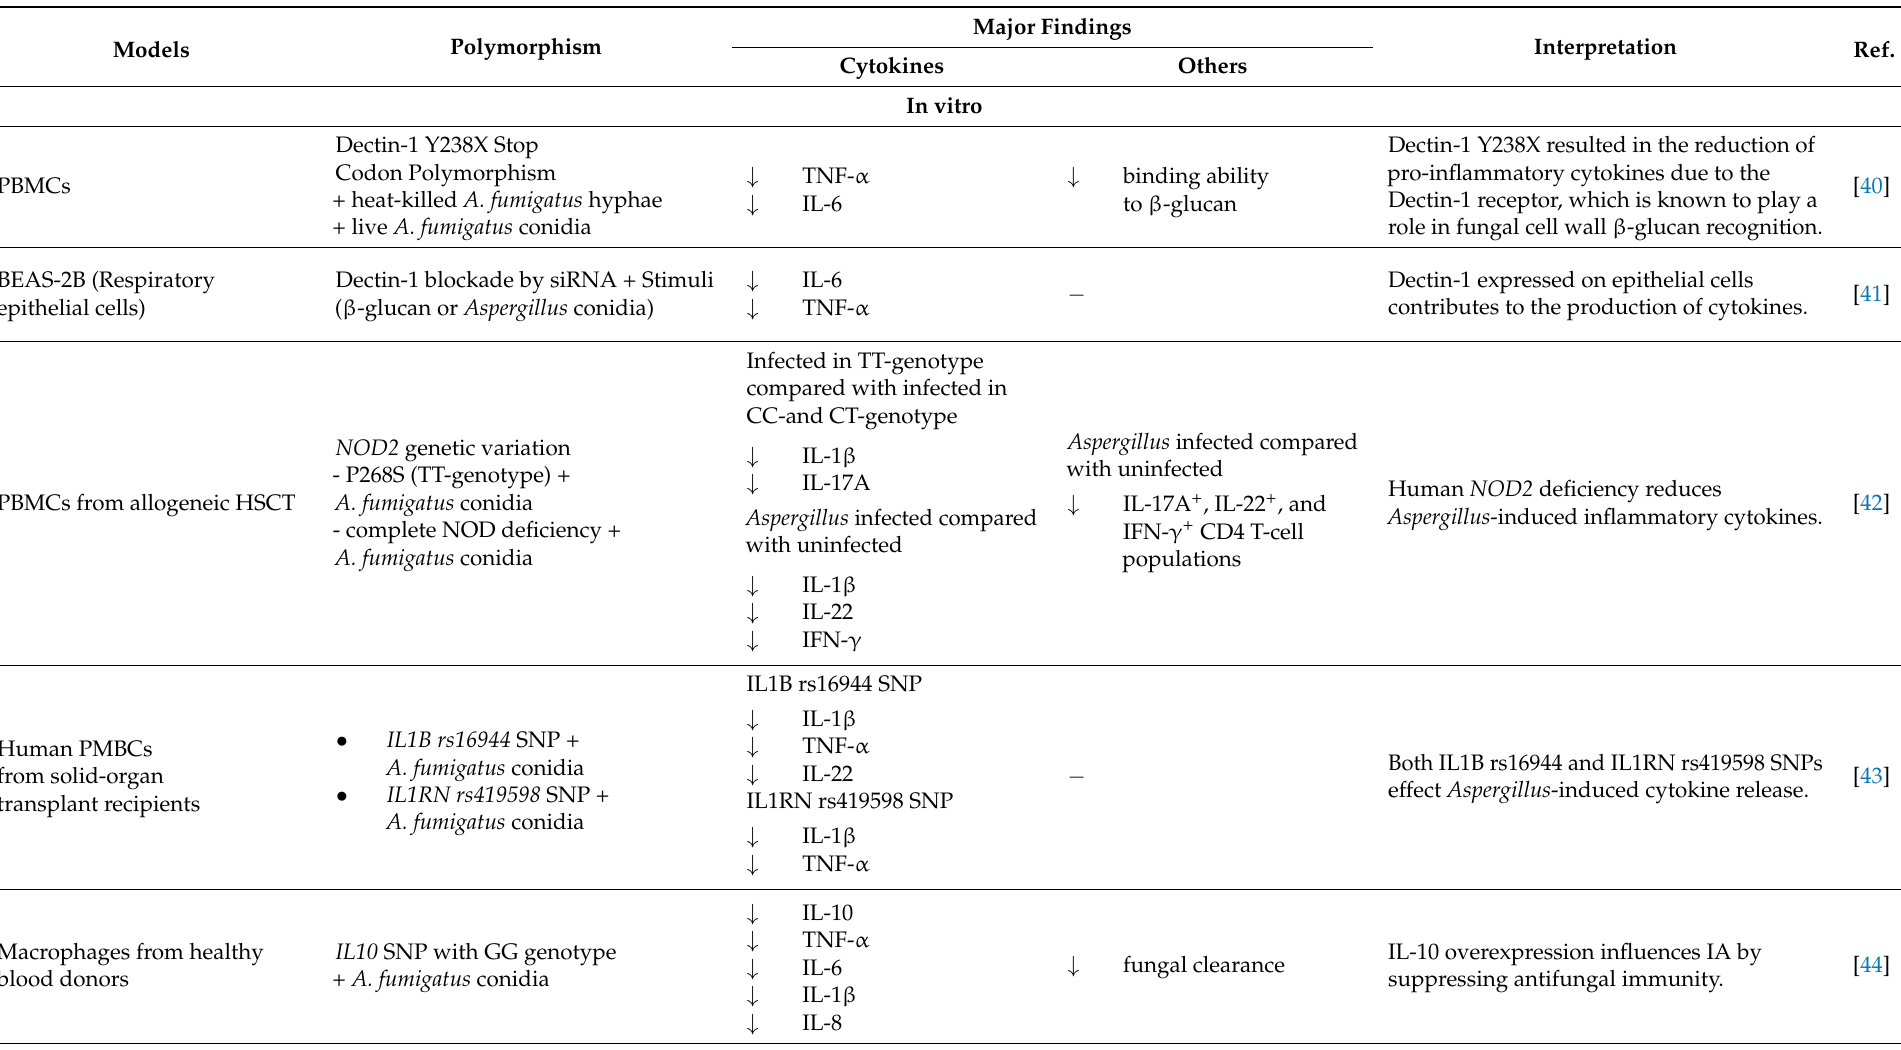
Table 2. Genetic polymorphisms in hematopoietic stem cell transplantation patients are associated with susceptibility/resistance to invasive